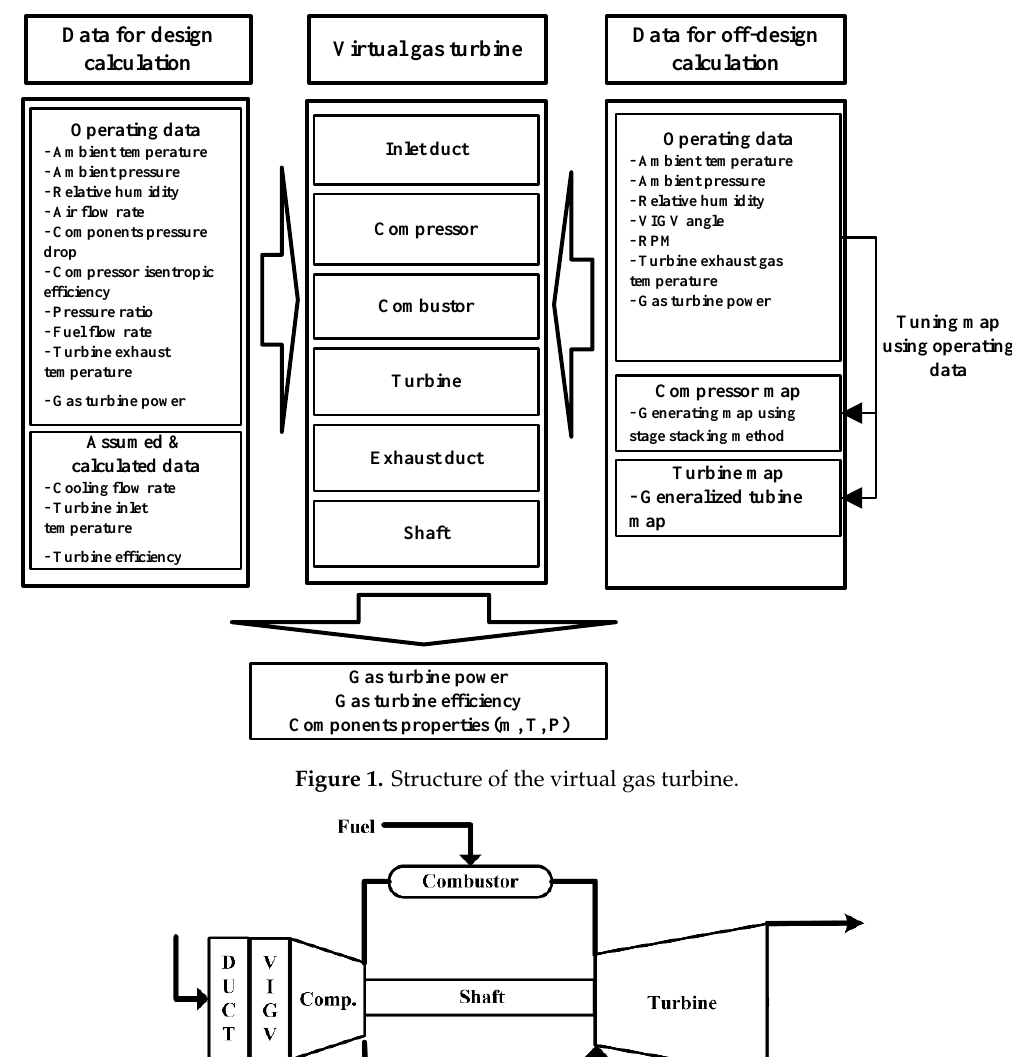
Figure 2. Configuration of the gas turbine for simulation.